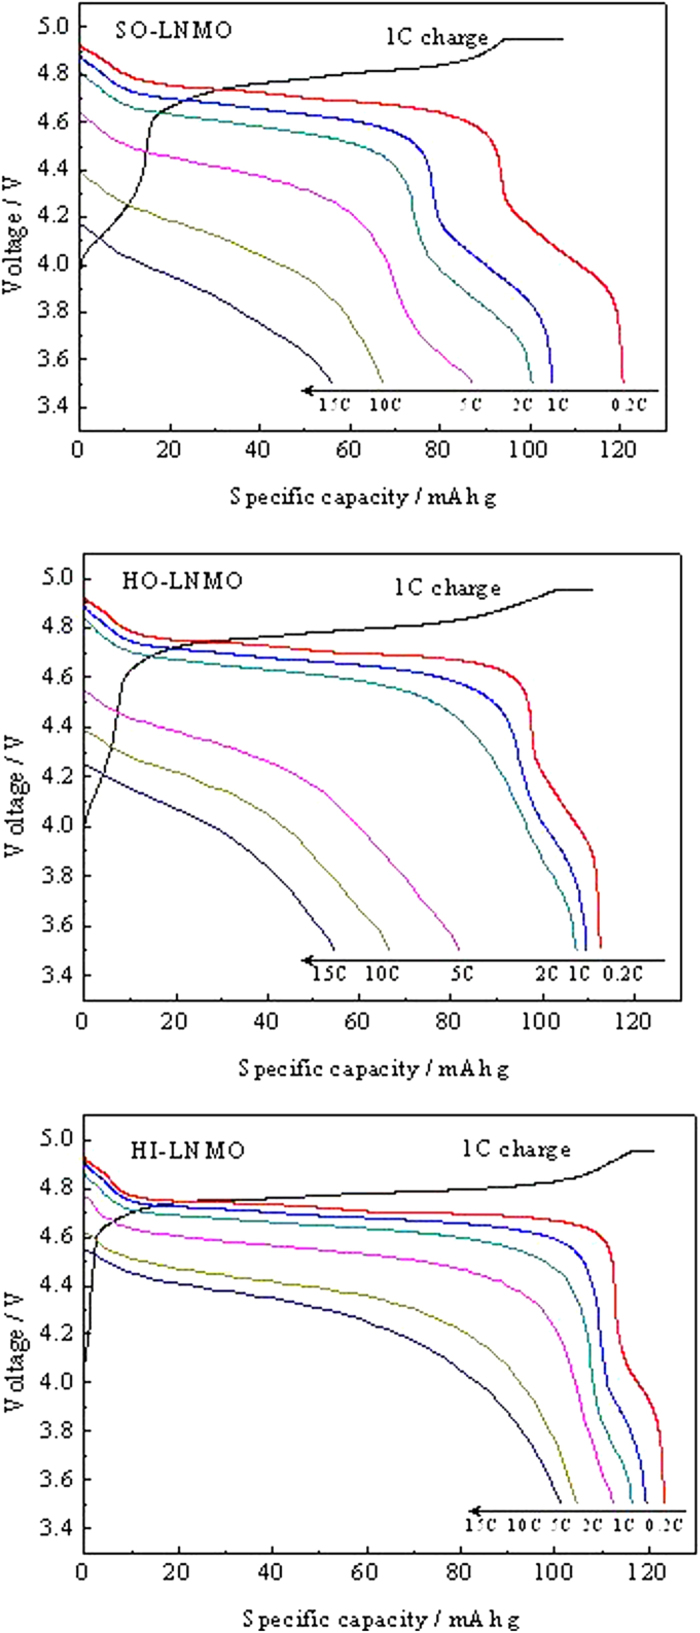
Charge and discharge capacity curves of LiNi0.5Mn1.5O4 with different microstructures.